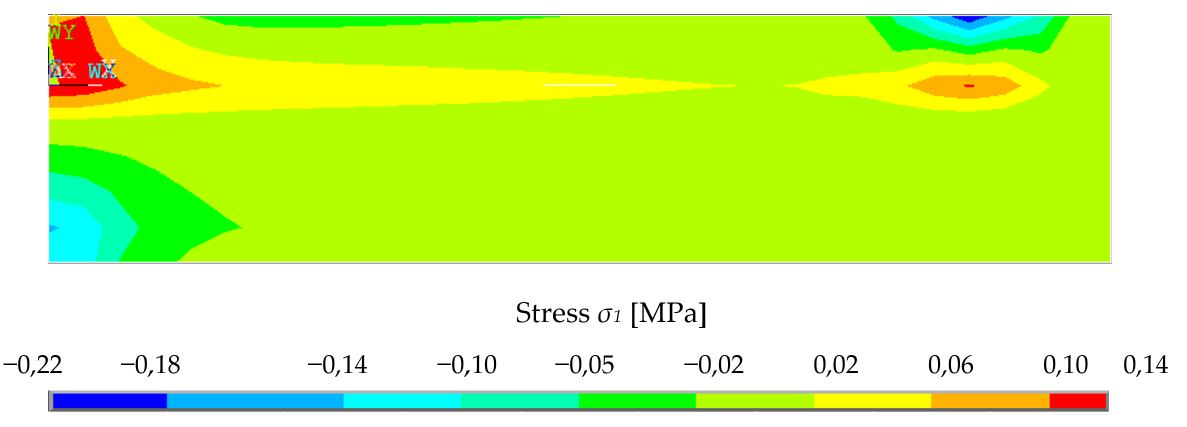
Figure 29. Stresses iso-areas over longitudinal-section for interaction of two materials.